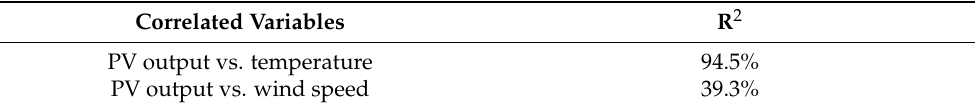
Table 3. R-squared values for the relationship between hourly temperature and wind speed with the PV system output.